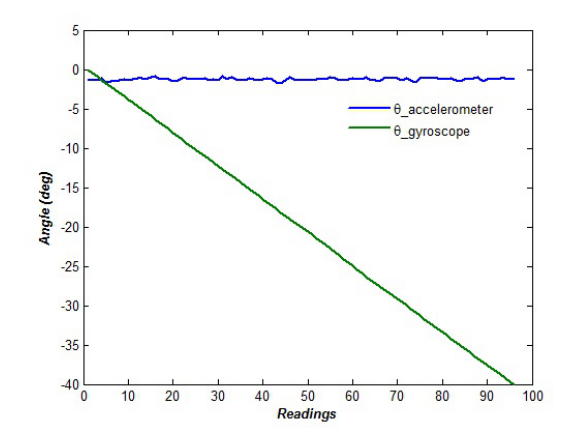
Figure 5: Gyroscope drifts in a stable position.